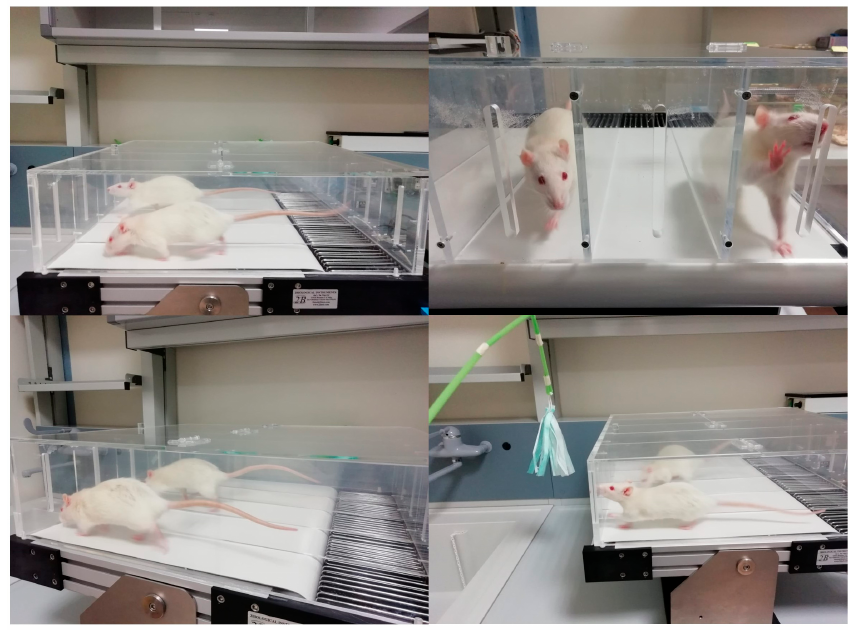
Figure 2. Rats exercising on the treadmill. Speeds and the durations were gradually incremented, respectively, from 10–15 m/minute for 5 min to 40–50 m/min for 25 min (from week 1 to week 16).